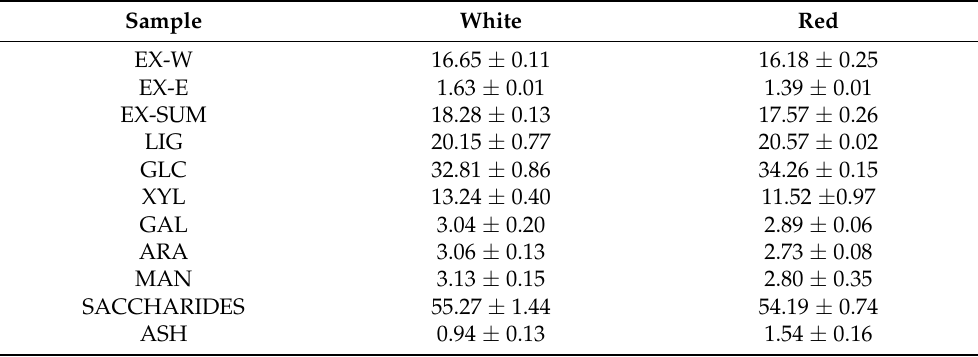
Table 1. Extractive, lignin, and saccharide content in grape cuttings (% odw; mean ± standard deviation).